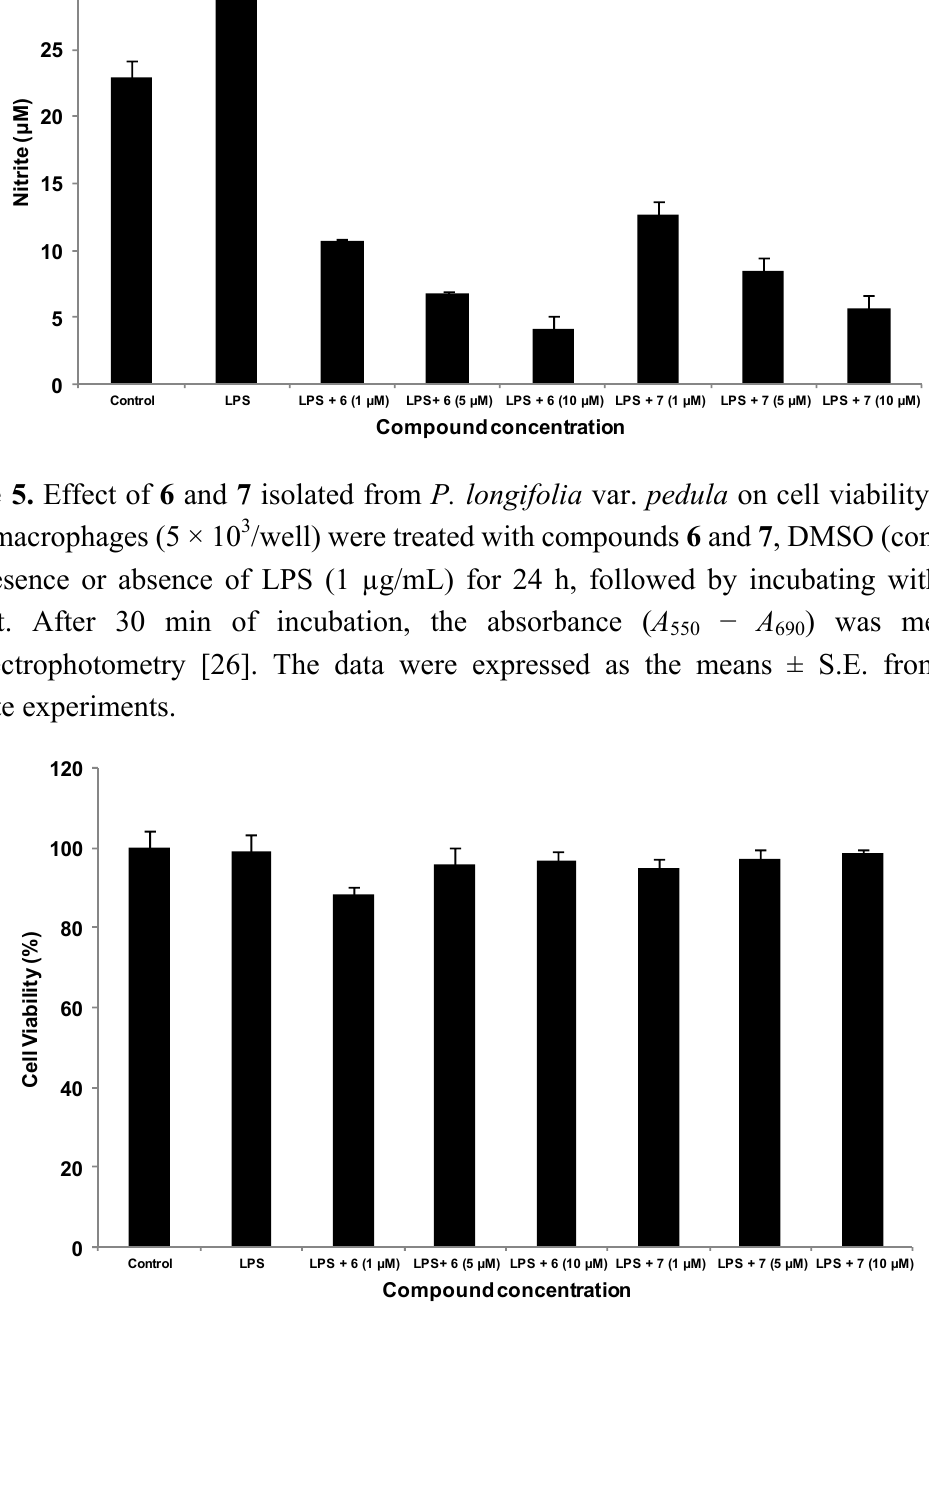
Figure 4. Effect of 6 and 7 isolated from P. longifolia var. pedula on the expression of RAW 264.7 NO. RAW 264.7 macrophages (5 × 10 5 /mL) were pre-treated with compounds 6 and 7 , and DMSO (control) for 30 min, followed by stimulation with LPS (1 µg/mL) for 24 h. NO concentration in the culture medium was assayed by the Griess reaction. The data were expressed as the means ± S.E. from three separate experiments.